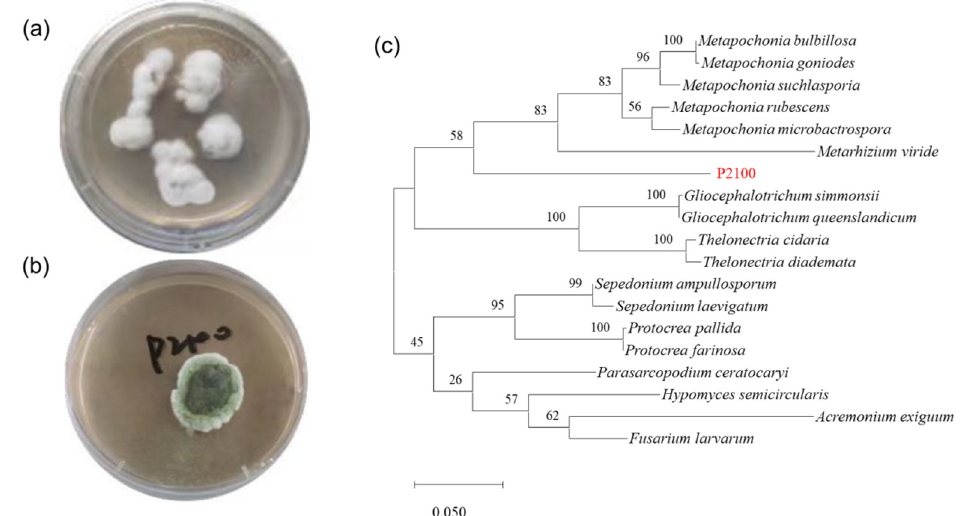
Figure 1. Species identification of the marine-derived fungal strain P2100. ( a ) Colony and ( b ) conidiation morphology of P2100 was observed by growth on a PDA plate for 3 and 7 days, respectively. ( c ) Phylogenetic tree of fungal strain P2100 based on ITS sequences by using maximum likelihood method with 1000 bootstraps.